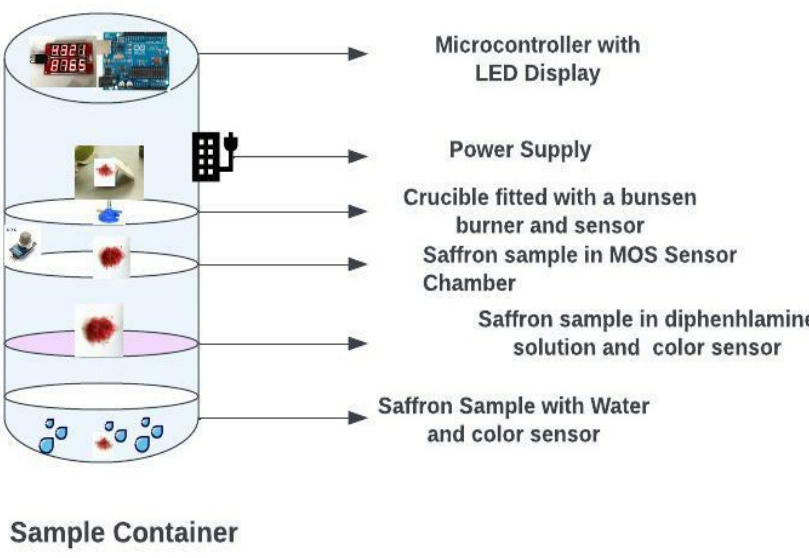
Figure 5. Smart saffron quality check chamber.